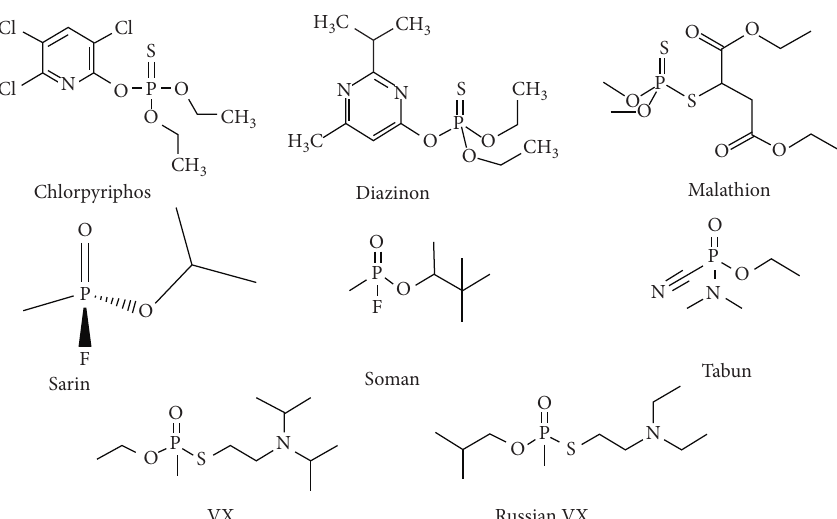
Figure 1: General structure of OP pesticides and chemical warfare agents (structures obtained from https://pubchem.ncbi.nlm.nih.gov/). (a) Chlorpyriphos, (b) diazinon, (c) malathion, (d) sarin, (e) soman, (f) tabun, (g) VX, and (h) Russian